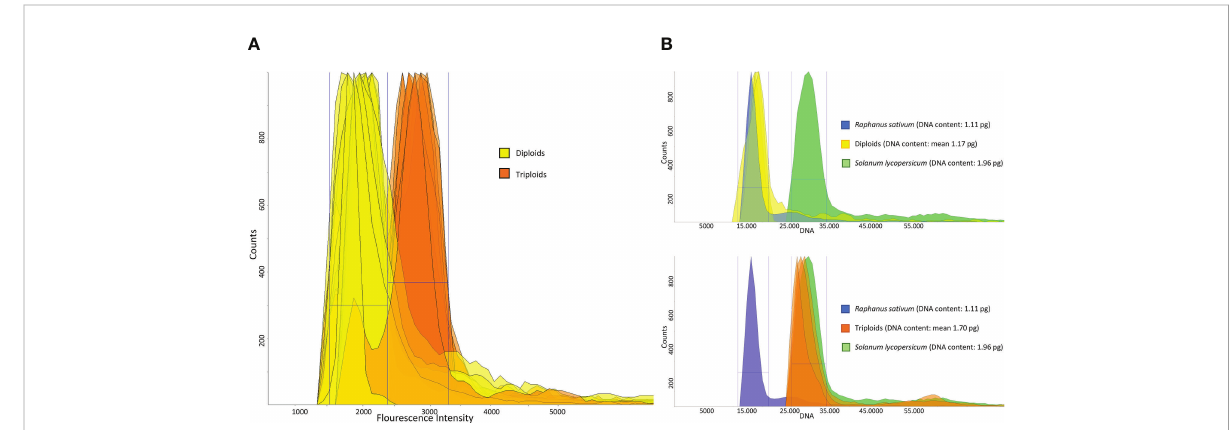
FIGURE 1 (A) DAPI-based fl ow cytometry measurements of 50 pear accessions. The peaks in yellow indicate the diploid region, whereas the orange- colored peaks represent the triploid area. (B) Genome size estimates of three diploid and three triploid accessions. Each peak represents the total DNA fl uorescence emission of propidium iodide (PI)-stained leaf nuclei of diploids (yellow, upper part) and triploids (orange, bottom part). In both cases, each sample was cochopped and corun with two reference samples, namely, Raphanus sativum L. (blue peak) and Solanum lycopersicum L. (green